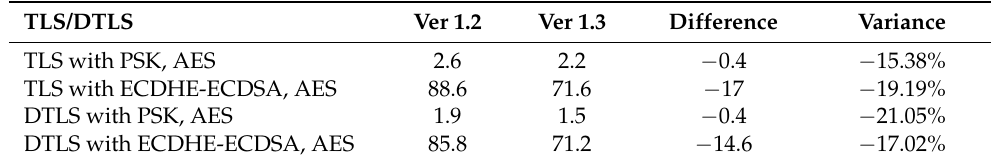
Table 3. Energy-consumption comparison.